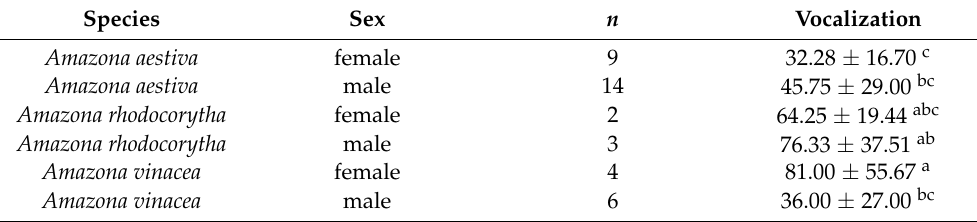
Table 4. Effects of the interaction sex*species on the number of vocalizations during the restraint test (estimated means ± standard